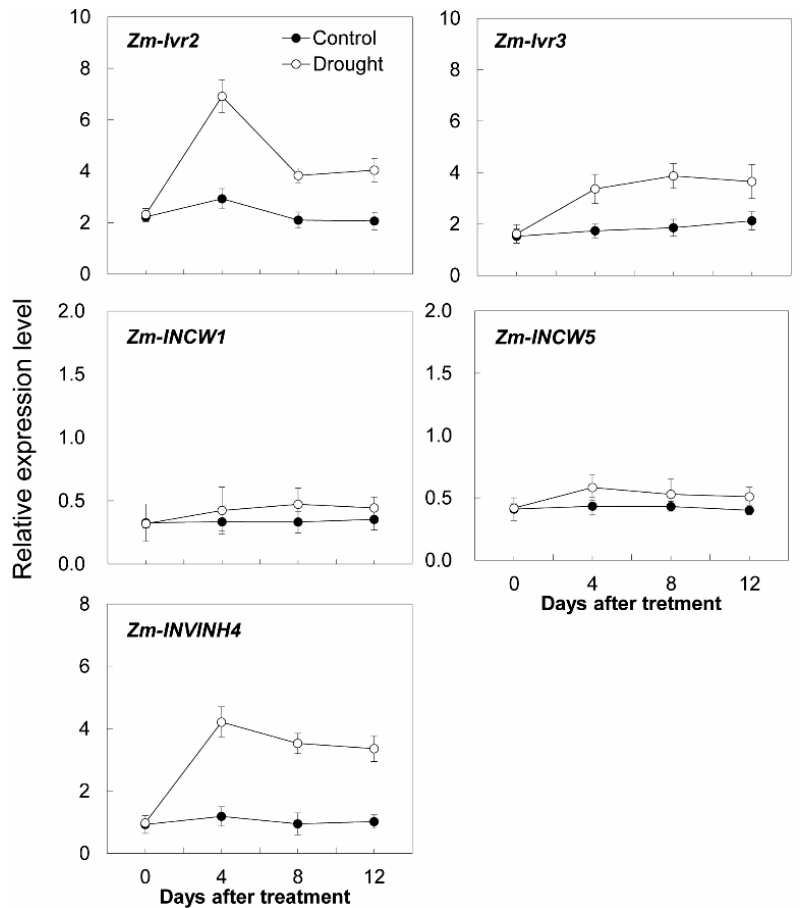
Figure 10. Effect of drought stress on relative expression of invertase and invertase inhibitor-related genes in the maize sink part of the leaf. Gene expression levels were determined by quantitative real-time PCR and were normalized against the maize actin and ubiquitin genes. Data represents mean ± SE of at least three independent biological replicates.